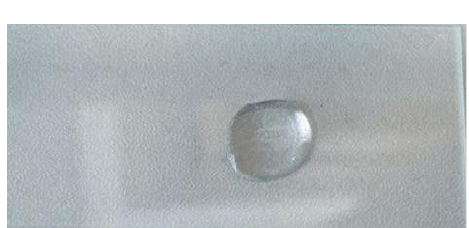
Figure 4: The morphology of S. sanguinis colonies Figure 5 : Microscopic appearance of on MSA plate